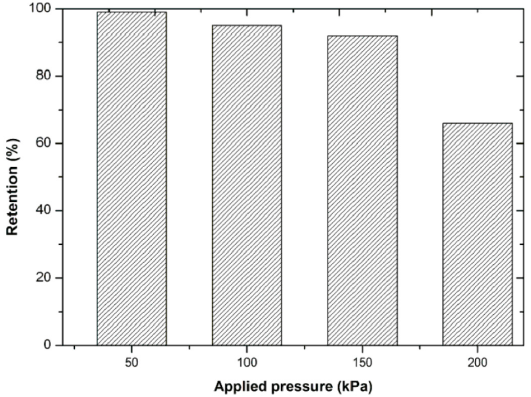
Figure 8. Retention of Escherichia coli bacteria at different pressures applied to the mullite tubular ceramic membrane (alumina and